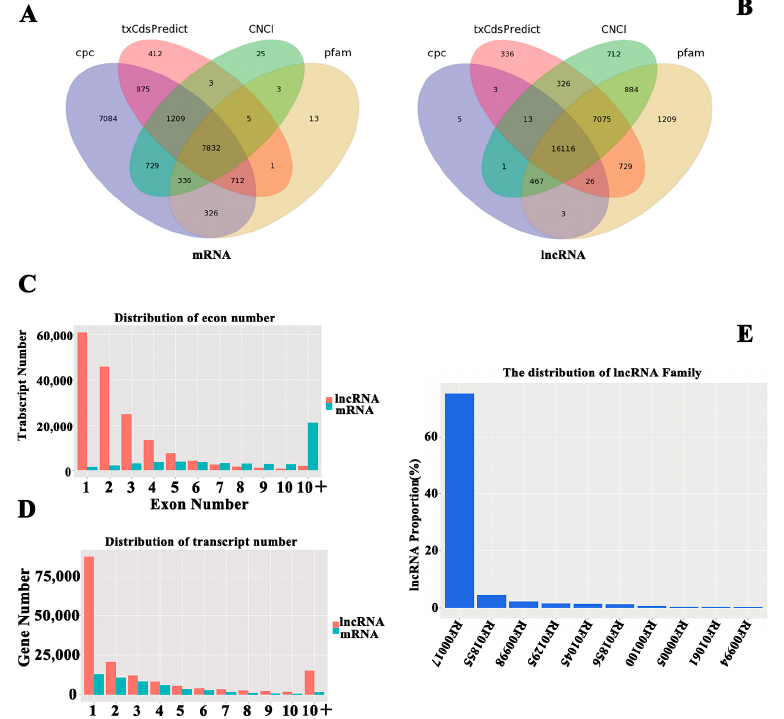
Figure 3 . Identification of lncRNAs and mRNAs in hHSC myofibroblasts. Three computational Figure 3. Identification of lncRNAs and mRNAs in hHSC myofibroblasts. Three